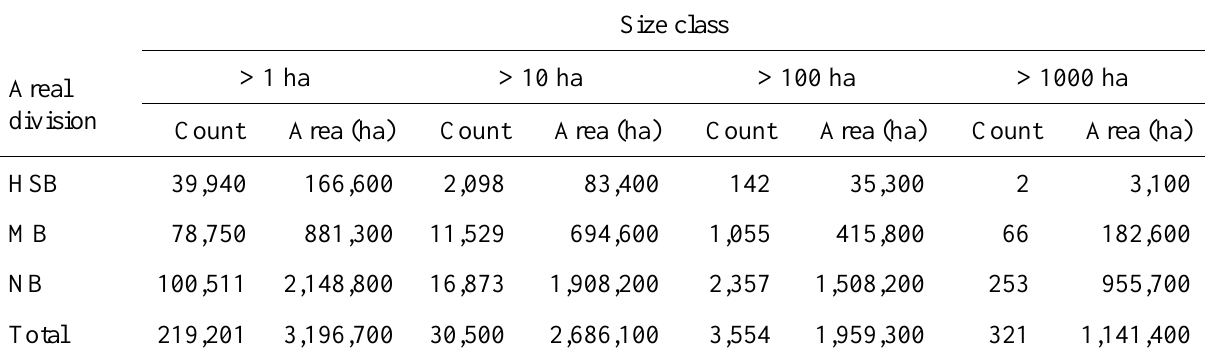
Figure 5. Areas of drained and undrained peatlands in Finland according to the drainage status raster. Peatland refers to all peat-covered areas, including forested environments and areas with thin layers of peat less than 30 cm thick. HSB = hemiboreal and southern boreal zone, MB = middle boreal zone, NB = northern boreal zone. Table 4. Number and area of undrained peatland patches of different size classes in